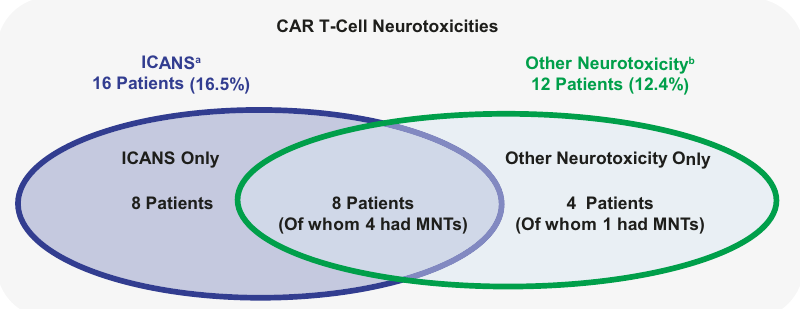
Fig. 1 Overview of CAR T-cell neurotoxicities in CARTITUDE-1. a ICANS per ASTCT consensus criteria. b Neurotoxicity as assessed by the investigator to be related to cilta-cel occurring after a period of recovery from CRS and/or ICANS. ICANS and other neurotoxicity events are not mutually exclusive; eight (8.2%) patients experienced both ICANS and other neurotoxicity events of any grade. Patients in the other- neurotoxicity group ( n = 12) include the subset with MNTs ( n = 5). ASTCT American Society for Transplantation and Cellular Therapy, CAR